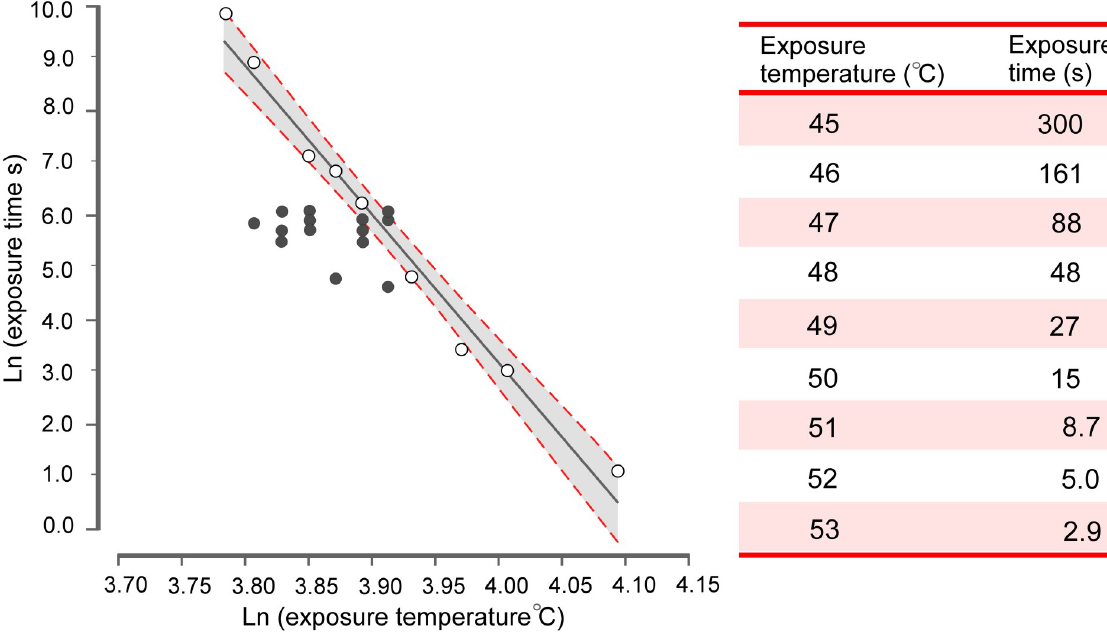
Fig 2. Time-temperature relationship of the contact burn injury. Double-logarithmic time-temperature relationship of the burn injury (left panel) and inclusion criteria for minimum exposure temperature and exposure time (right panel). The grey line represents a regression plot with 95% confidence bands (dashed red lines) on the logarithmic relationship between exposure temperature (X) and exposure time (Y) in producing a burn injury (modified from Naert et al. [27] based on data from Moritz and Henriques [72]; Y = -28.3 � X + 116.4, R 2 = 0.98). The open circles represent the longest exposure time at a given temperature that failed to destroy the epidermis but induced a hyperemic skin response in humans. The red line is a parallel shift of the regression line through the heating paradigm of 300 s at 45˚C (Y = -28.3 � X + 113.4), serving as a ‘safety margin’ and inclusion criteria in this review (see right panel for specific values). The solid grey circles represent the heating paradigms of the included studies. The minimum exposure time at a given temperature that meets the inclusion criteria is outlined in the table (right panel, corresponding to the parallel shifted red